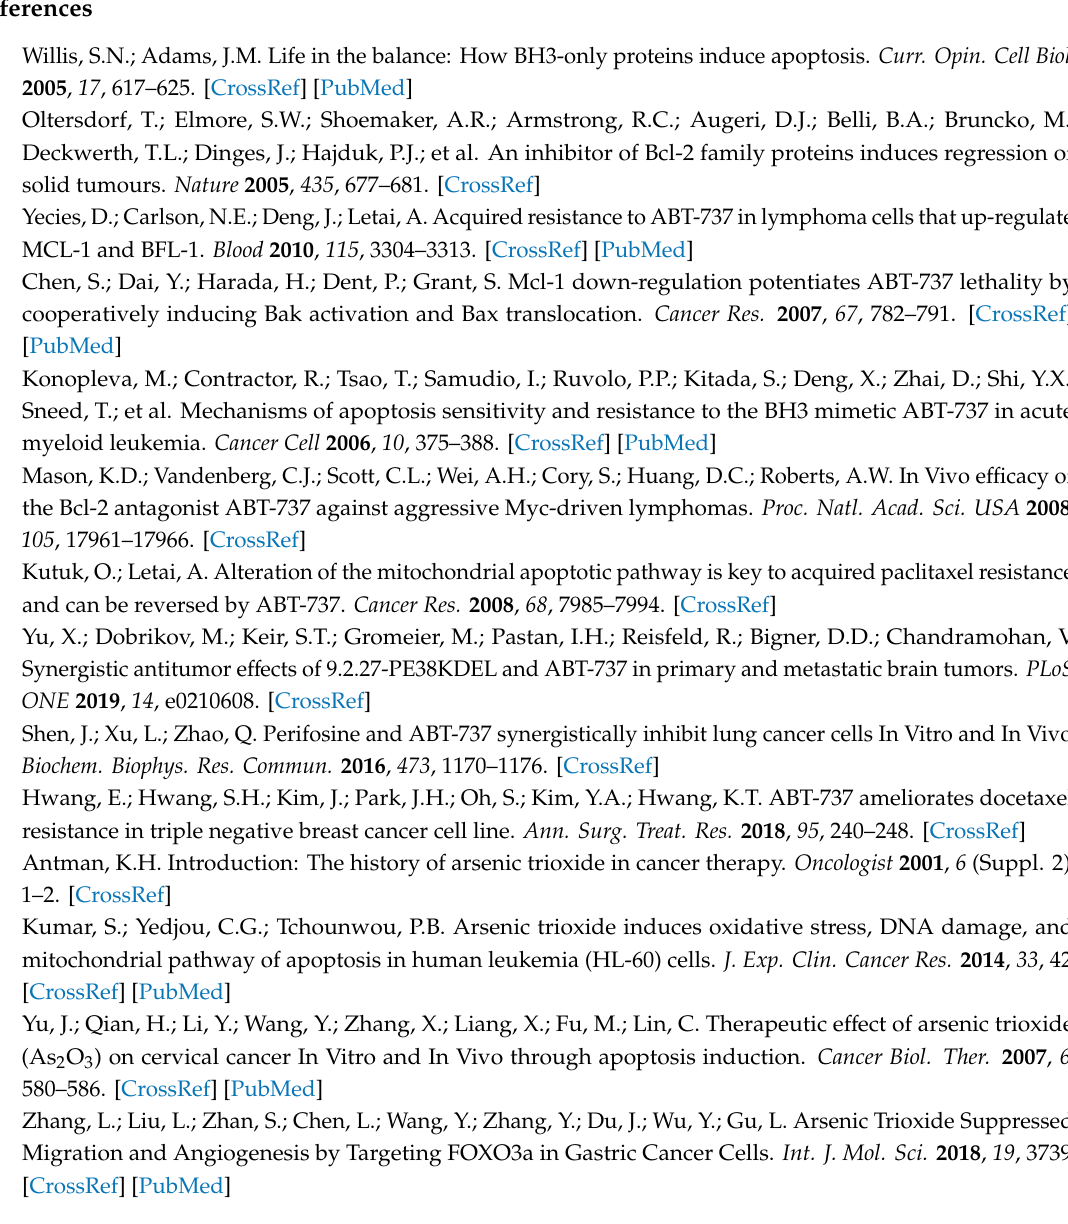
Figure S1: E ff ect of ABT-737 and As 2 O 3 on cell viability in Mouse Embryonic Fibroblasts (MEF) and human keratinocyte cell line, HaCaT, Figure S2: E ff ect of pan-caspase inhibitor Z-VAD-FMK on cell viability in SiHa and Caski cells after ABT-737 and As 2 O 3 treatment, Figure S3. Wetern